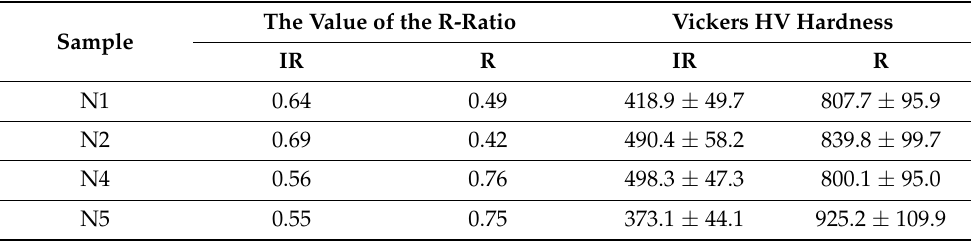
Table 2. Characteristic values of R-ratio and Vickers HV hardness of mineralized tissue samples determined from Raman micro-mapping and nanoindentation results for the enamel rod center region (R) and interrod region (IR).